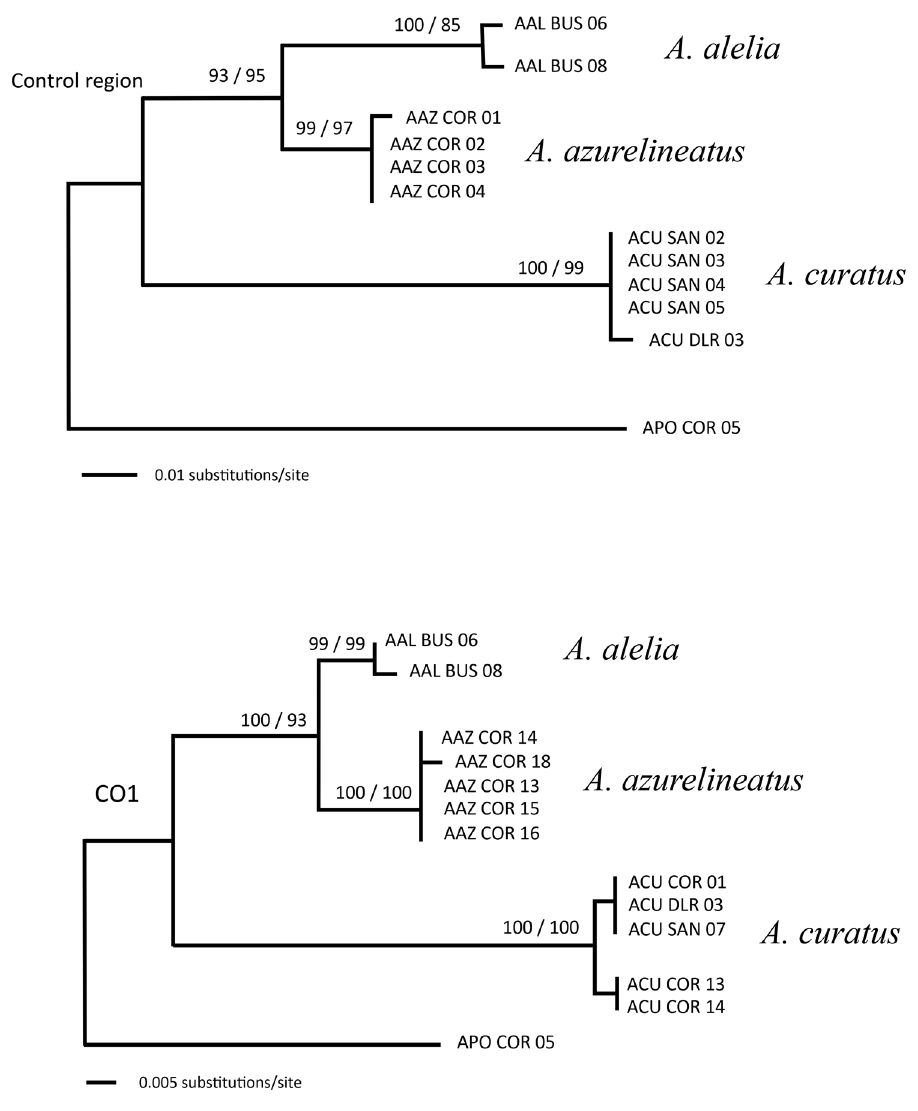
Figure 5. Phylogenetic reconstructions of Altrichthys species based on mitochondrial control region (313 aligned base pairs) and cytochrome oxydase 1 (CO1, 611 aligned base pairs). The closely related Acan- thochromis polyacanthus was used as an outgroup. Sample labels refer to collection sites: BUS, El Rio y Mar Resort, Busuanga Island, COR, Balinsasayaw Resort, Uson Island; SAN, Sangat Island; DLR, Dive Link Resort, Uson Island. Numbers above nodes refer to percent of 1000 bootstrap replicates used in Neighbor- Joining (left) and Maximum Likelihood (right) reconstruction